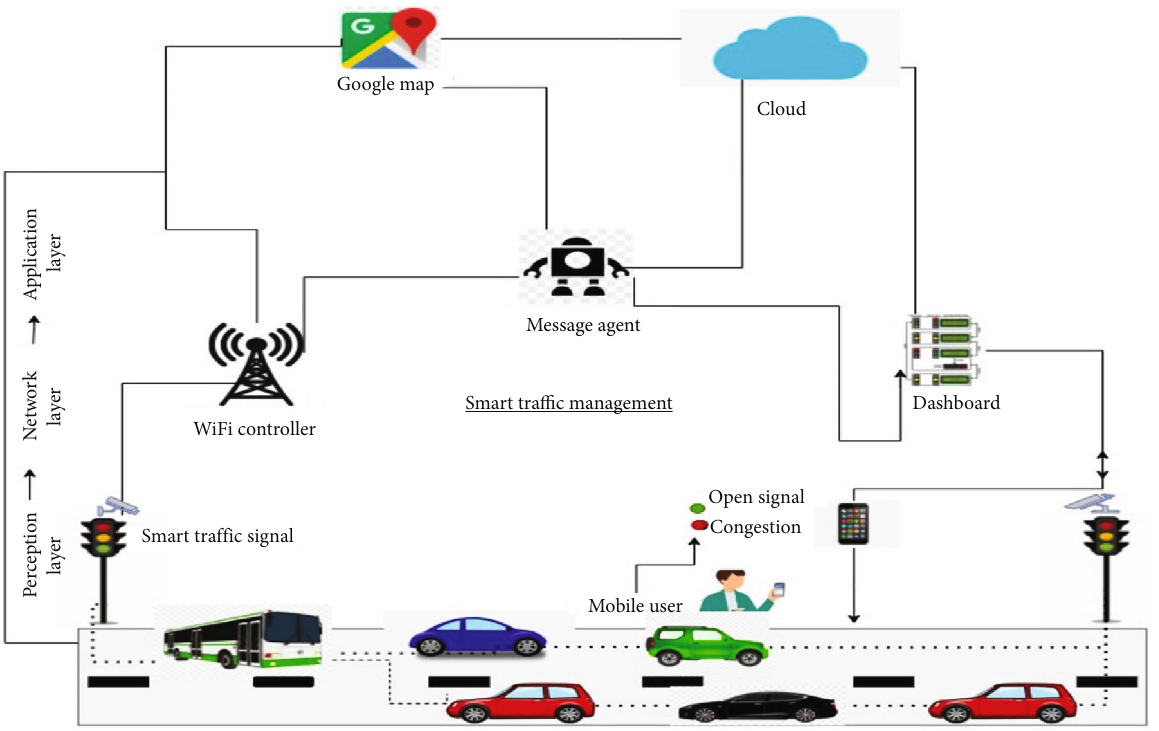
Figure 1: IoT-based architecture of Smart Tra ffi c Management System for metropolitan